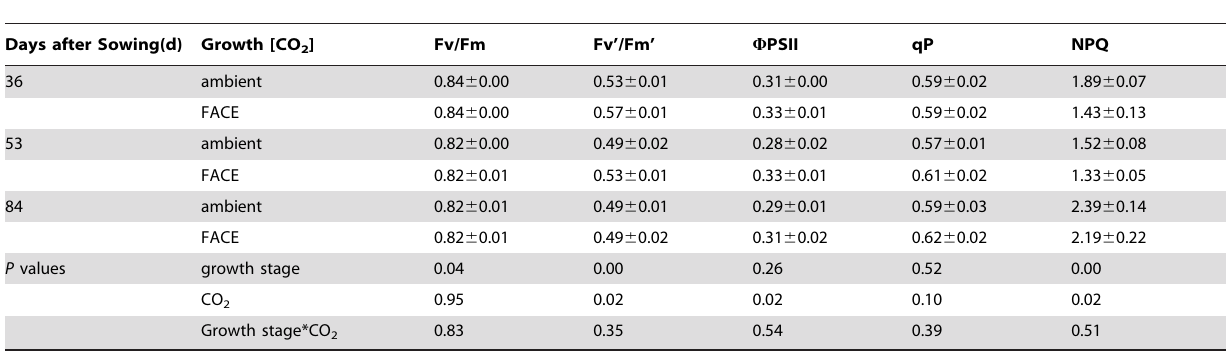
Table 2. Effects of elevated [CO 2 ] on chlorophyll fluorescence parameters in the last fully-expanded leaves of I. indigotica.